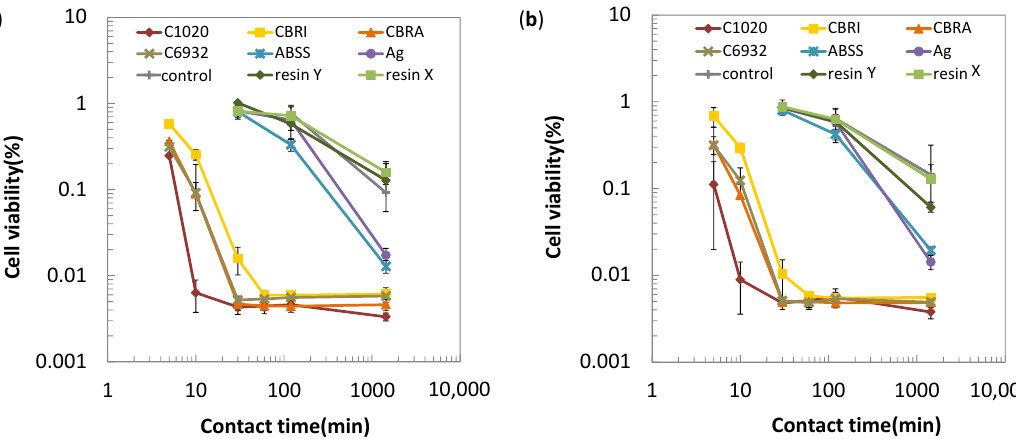
Figure 6. Antimicrobial activities of materials evaluated by the film method referring to JIS Z2801:2012 (ISO 22196) against Escherichia coli ( a ) and Staphylococcus aureus ( b ) (mean ± standard deviation).